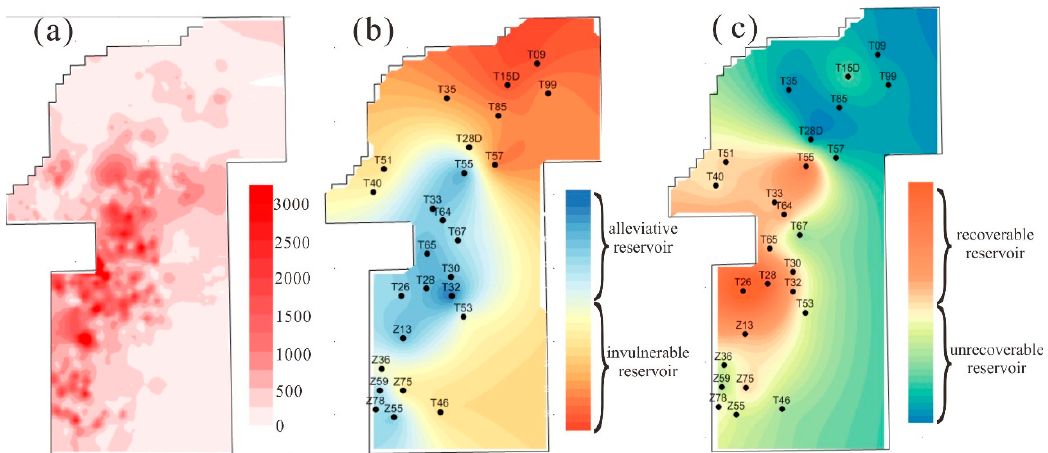
Figure 9. Distribution map of coal reservoir dynamic characterization in the Shizhuangnan block. ( a ) Distribution map of the maximum daily gas production (m 3 / d). ( b ) Damaged nature of permeability. ( c ) Recovery nature of permeability.